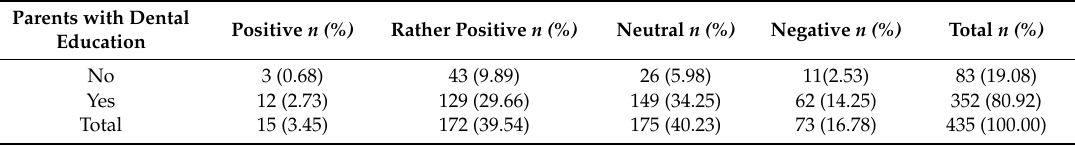
Table 3. Association between parents with dental education and career prospects. Distribution (number of participants and percentage) of the association between future career prospects and parents with dental education.